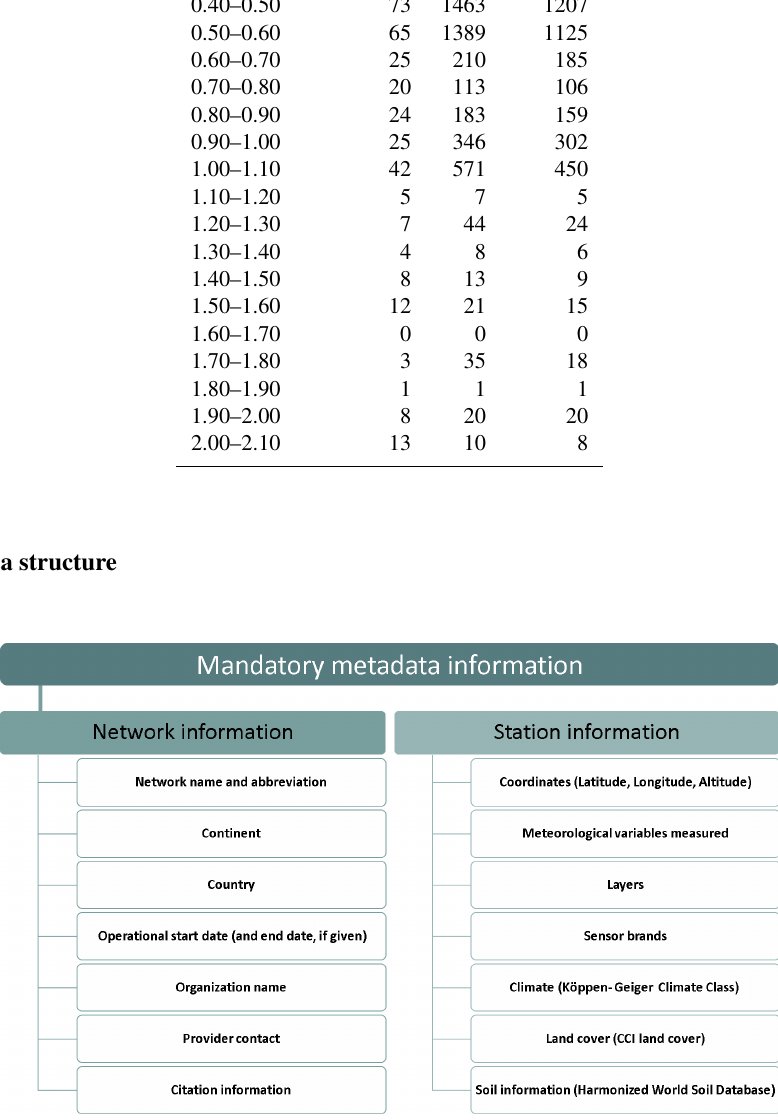
Figure D1. Overview of all mandatory metadata information available for each station within the ISMN